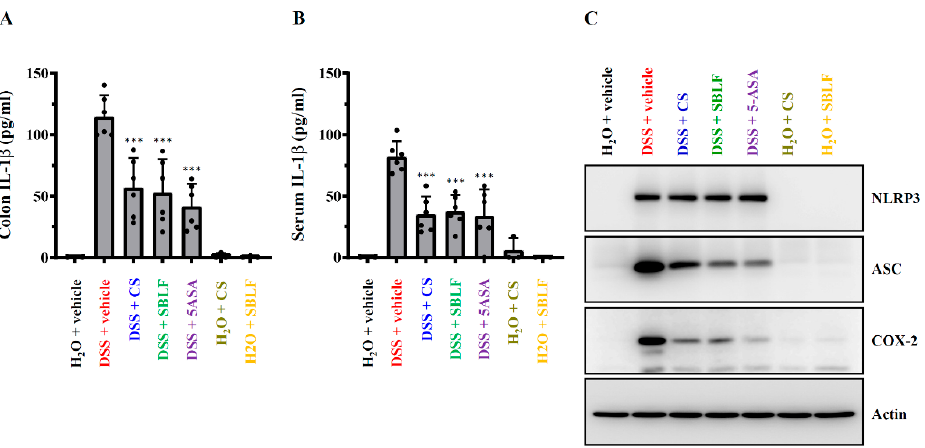
Figure 4. SBLF ameliorates NLRP3 inflammasome activation in DSS-treated mice. ( A ) IL-1 β concentration in colon tissue. ( B ) IL-1 β concentration in serum. ( C ) The Western blot image represents the protein expression levels in colon tissue. Bars show the mean ± SD. *** p < 0.001 compared to vehicle + DSS group.